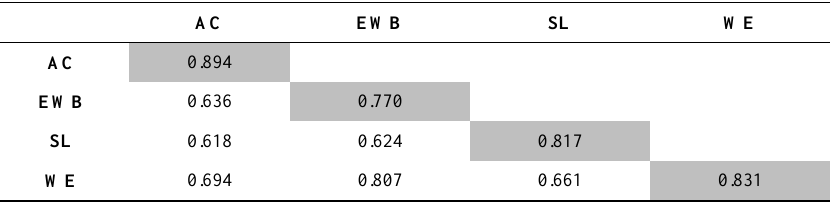
Table 3. Correlation matrix and discriminant validity